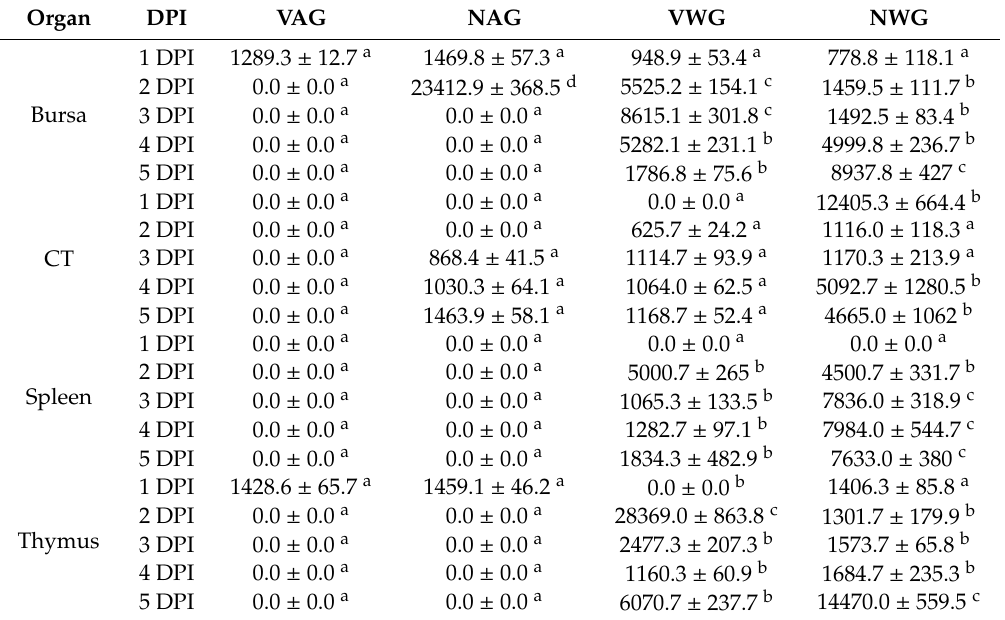
Table 5. Viral copy number (Mean ± SEM) in various organs of challenged birds.